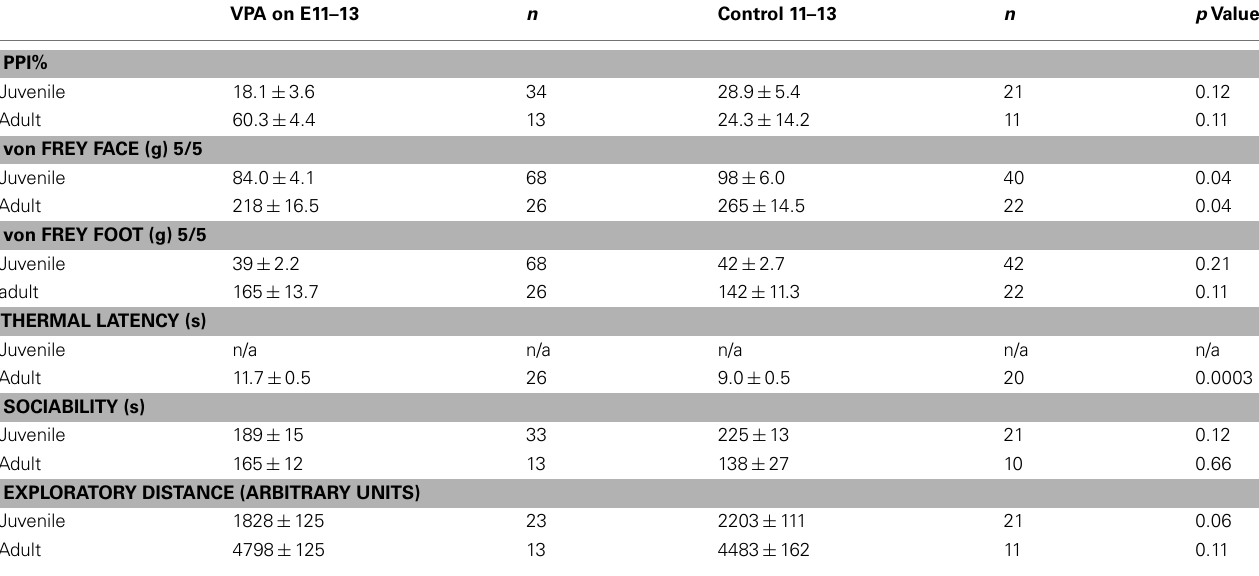
Table 3 | Summary of behavioral results for groups receiving multiple doses ofVPA or